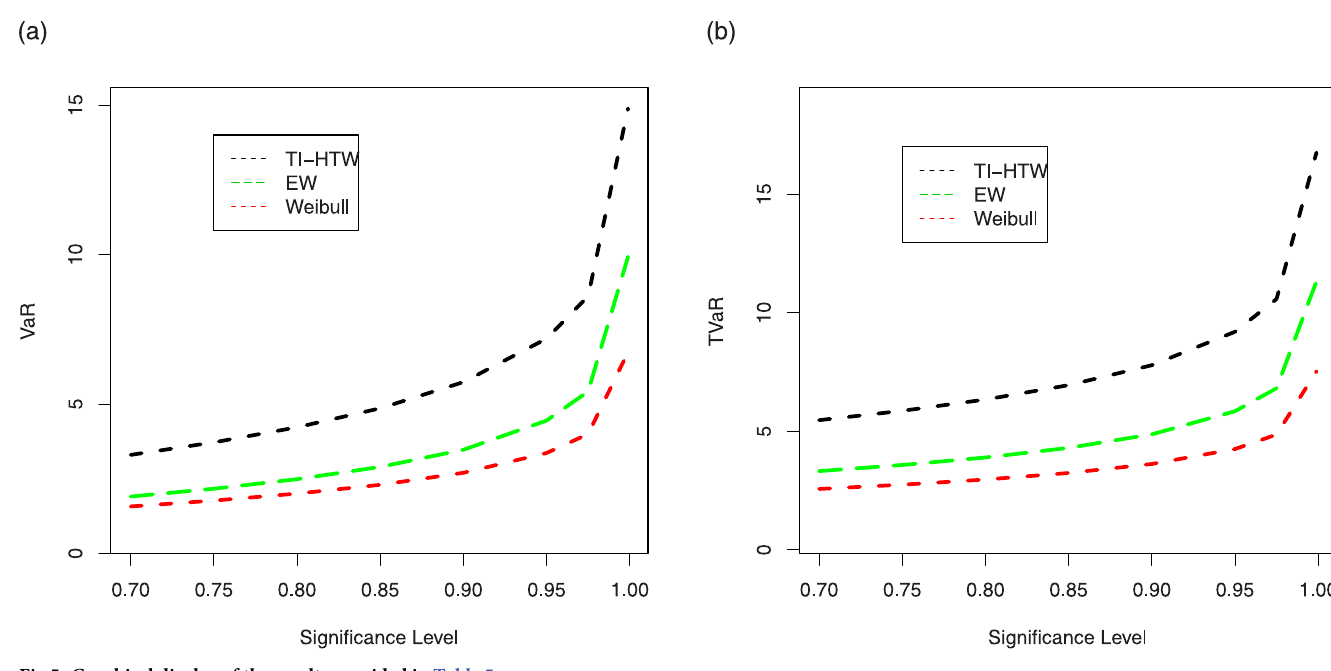
Fig 5. Graphical display of the results provided in Table 5.